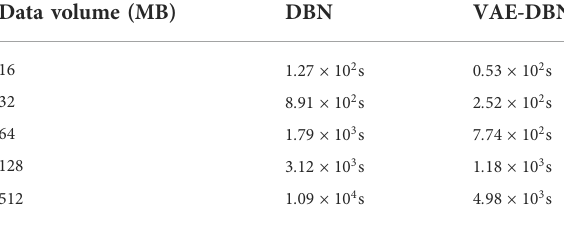
TABLE 8 Training ef fi ciency comparison of VAE-DBN and